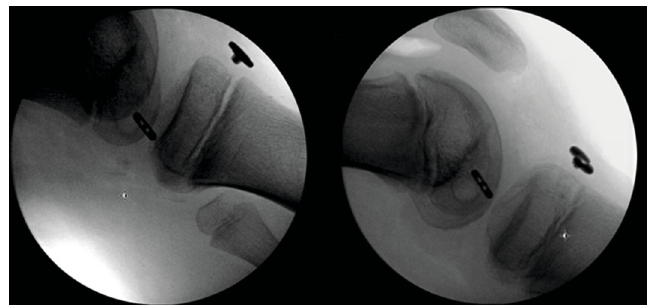
Figure 7: Fixation of the quadricep autograft soft-tissue buttons on both the femur and